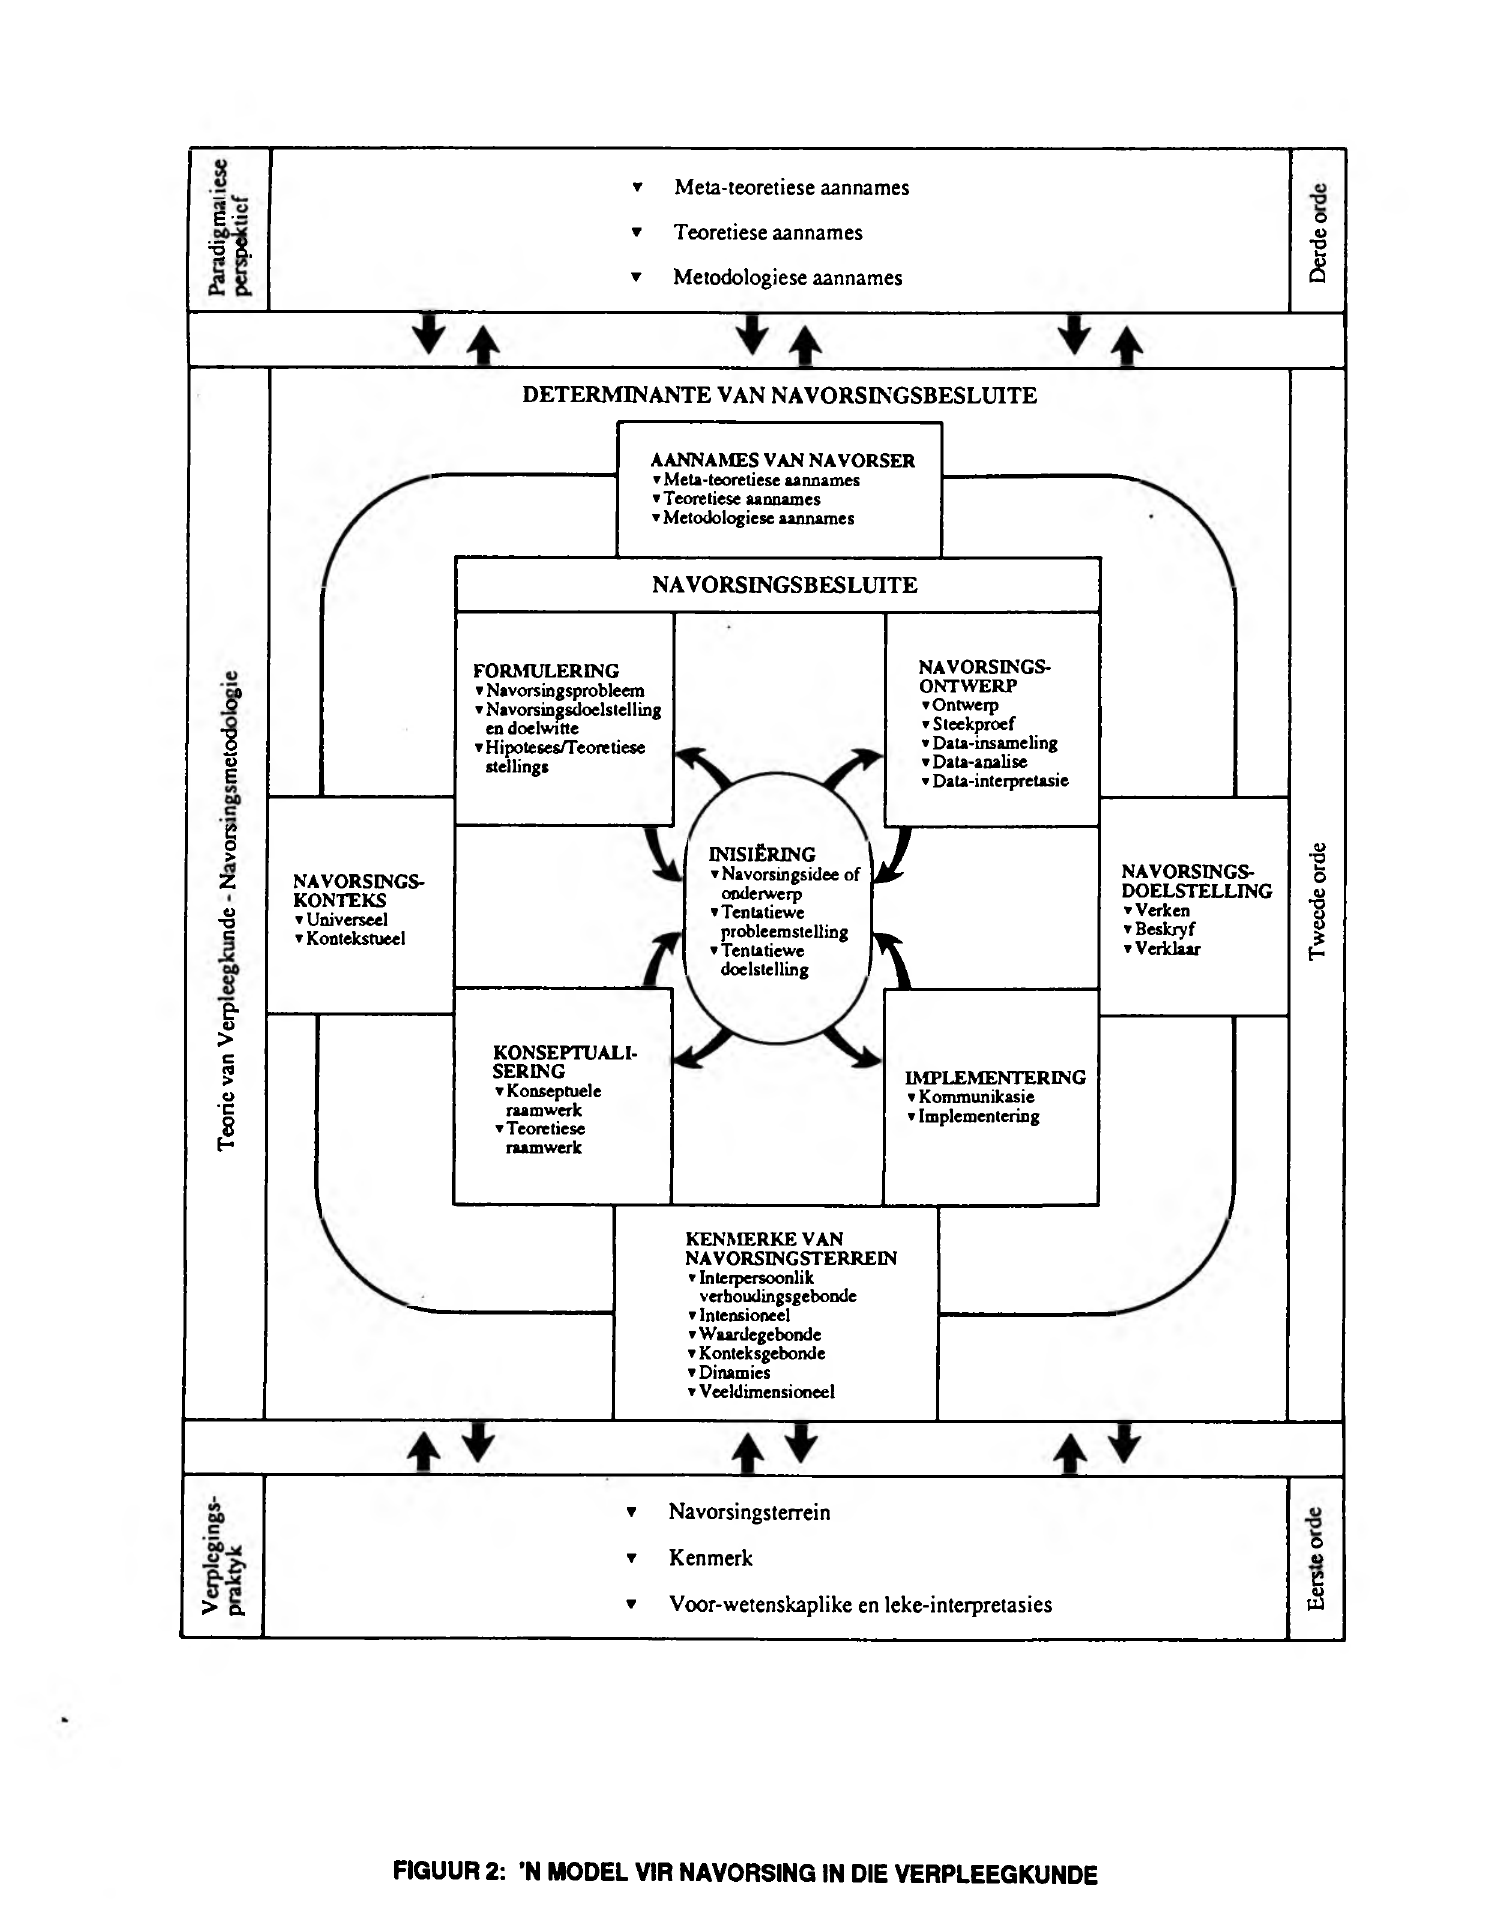
FIGUUR 2: ’N MODEL VIR NAVORSING IN DIE VERPLEEGKUNDE